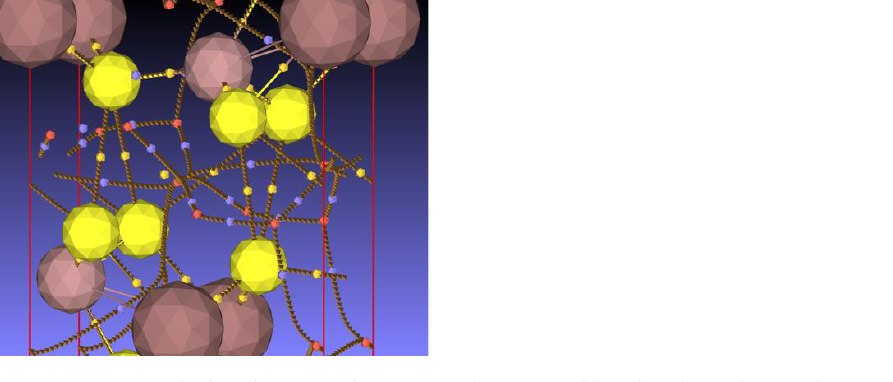
Figure 14. Focus on the bond, ring, and cage critical points and bond paths in the interlayer region of the structure. For the color legend, see the caption of Figure 13.